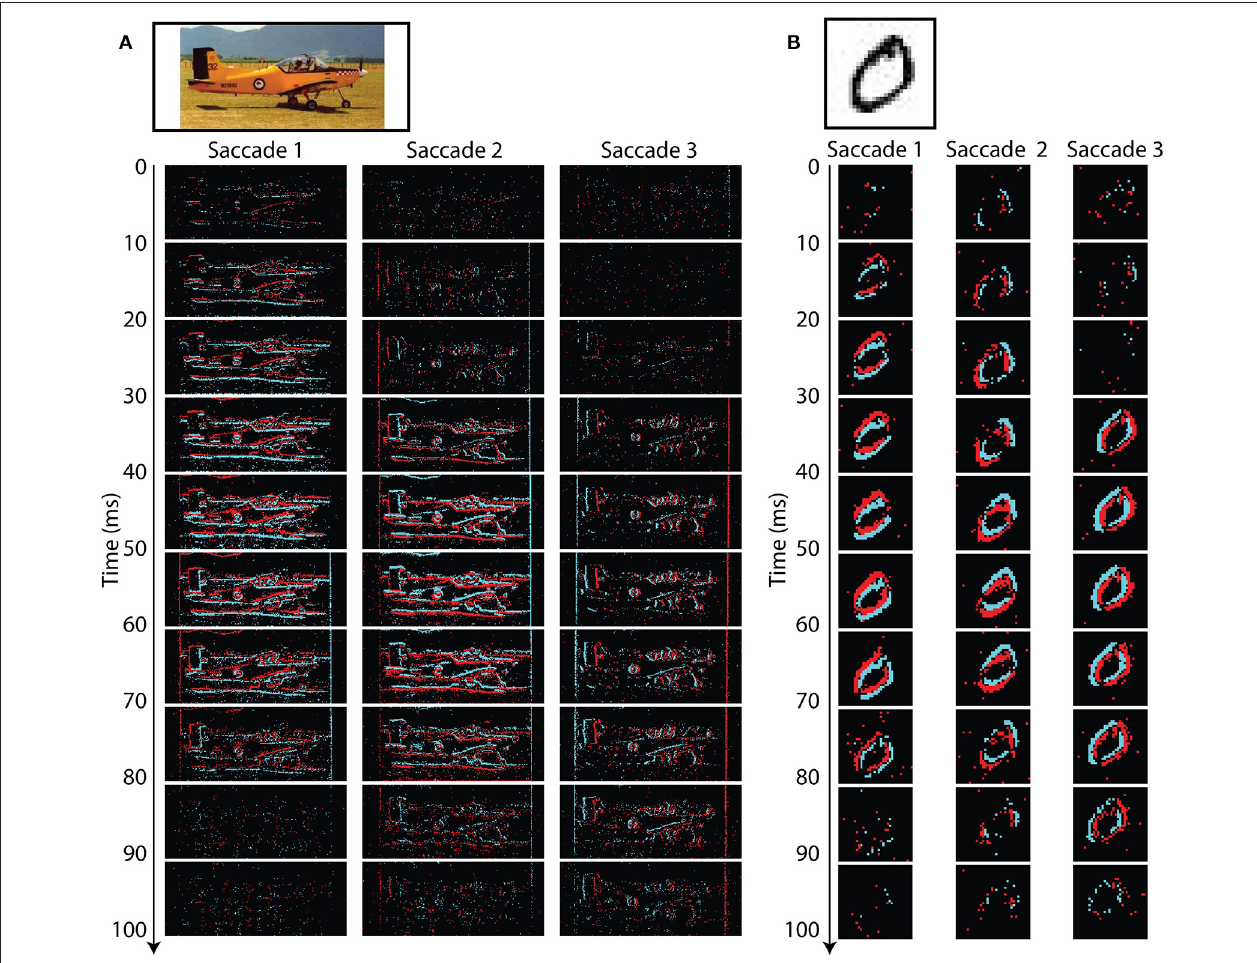
FIGURE 5 | Typical recordings for Caltech101 (A) and MNIST (B). The original images are shown at the top, and the recorded events obtained during each saccade are shown below. Each event image shows 10ms worth of data. Black regions indicate no events, red indicates ON events, and blue indicates OFF events. The third saccade is the shortest in distance and therefore generates the fewest events. Fewer events are recorded near the start and end of each saccade when the ATIS is moving